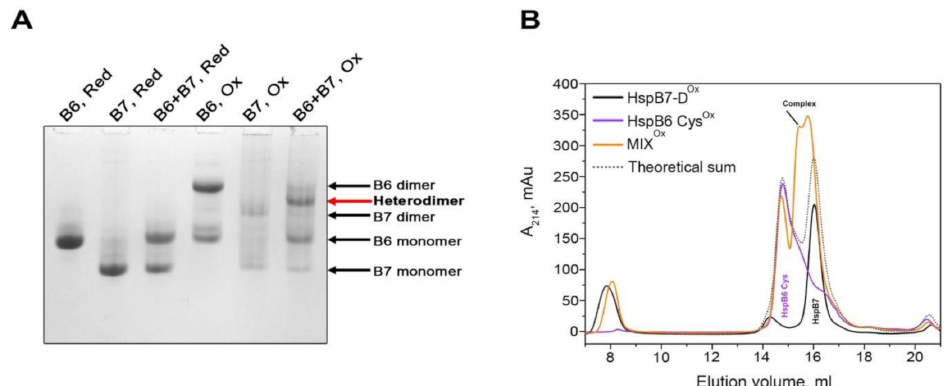
Figure 5. Interaction of HspB6 and HspB7. ( A ) Urea gel electrophoresis of the reduced Cys-mutant of HspB6 (B6, Red), reduced B7 (B7, Red), equimolar mixture of the reduced Cys-mutant of HspB6 and HspB7 (B6+B7, Red), oxidized Cys-mutant of HspB6 (B6, Ox), oxidized HspB7 (B7, Ox), and equimolar mixture of the oxidized Cys-mutant of HspB6 and HspB7 (B6+B7, Ox). Positions of monomers and dimers of HspB6 and HspB7 are marked by black arrows; position of the crosslinked HspB7/HspB6 complex is marked by red arrow. ( B ) SEC of oxidized HspB7 (HspB7-D Ox , black), oxidized Cys-mutants of HspB6 (HspB6 Cys Ox , violet), oxidized equimolar mixture of Cys-mutant of HspB6 and HspB7 (MIX Ox , orange), and arithmetic sum of elution profiles of isolated oxidized HspB6 and HspB7 (Theoretical sum, grey dotted